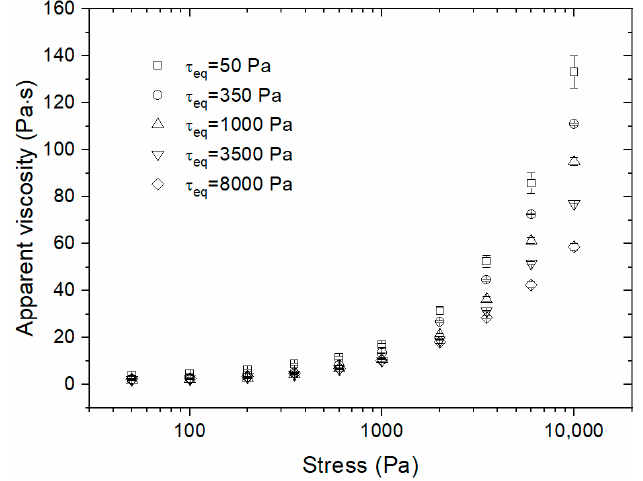
Figure 6. Apparent viscosity as a function of steps in shear stress. The figure shows a series of non-overlapped constant structure curves of R816/PPG400 suspension.